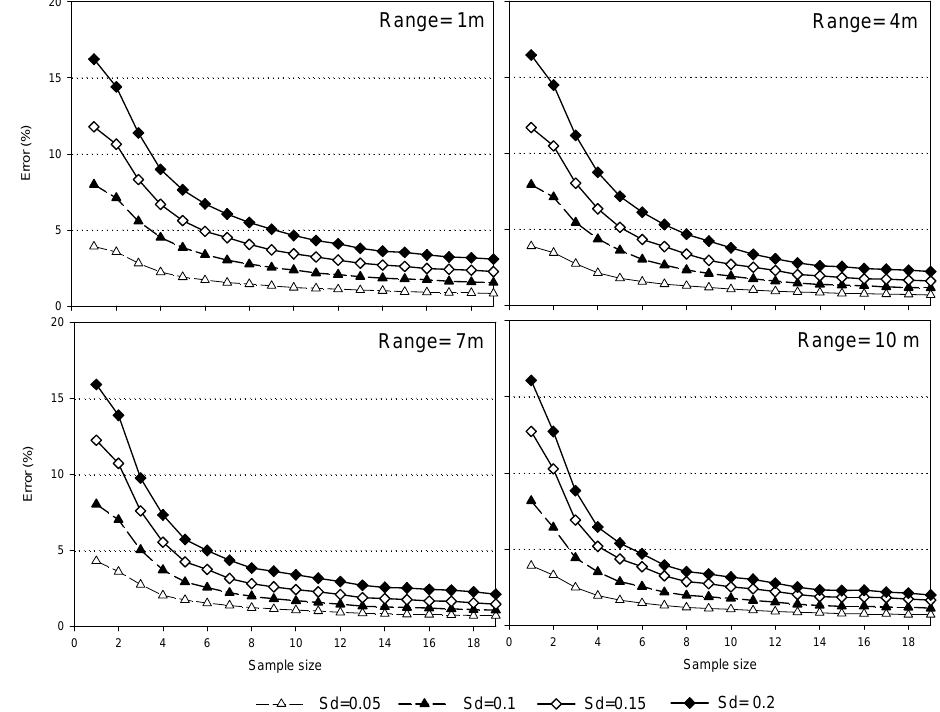
Figure 7 2 Fig. 7. Examples showing the decrease in average error according to sample size for 4 standard deviation levels with various classes of spatial